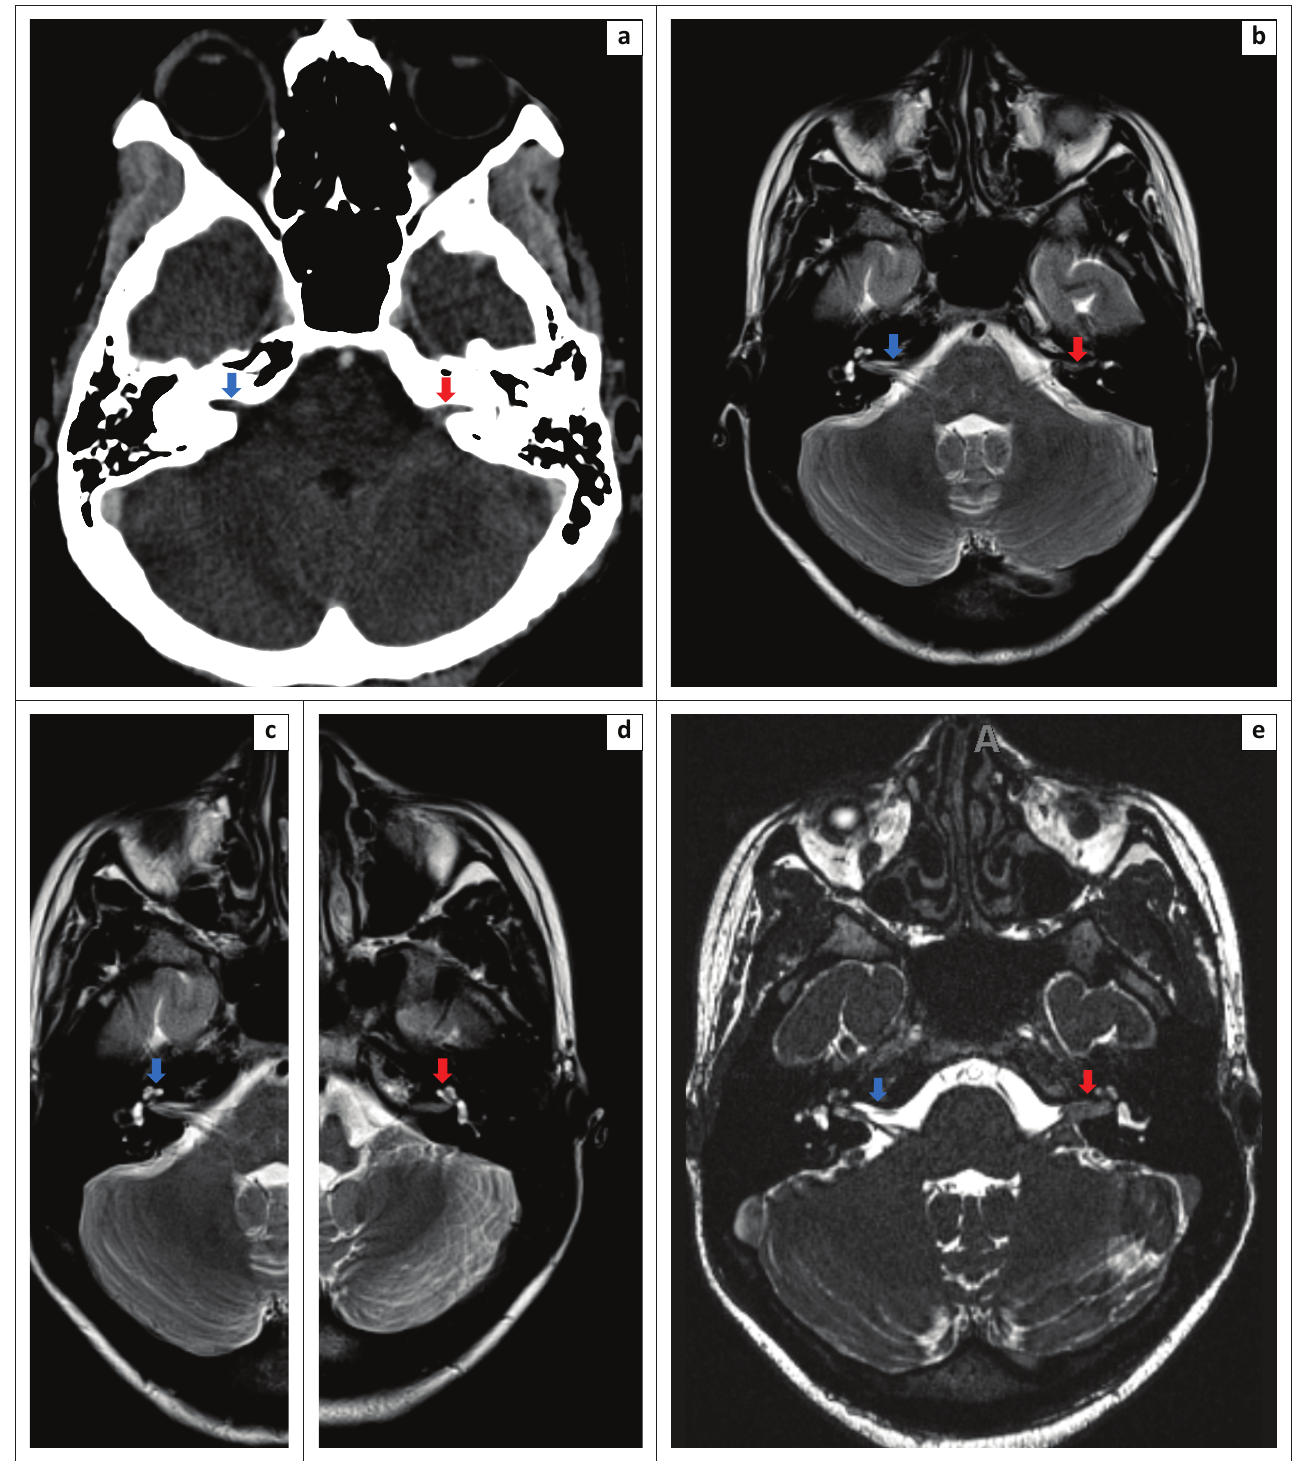
FIGURE 2: (a) Axial CT brain scan demonstrated a hyperattenuating mass at the porous acousticus of the left internal acoustic canal (red arrow). There was mild contrast enhancement and the canal was not expanded. The right internal acoustic canal appeared normal (blue arrow). (b) Axial, T2W MRI of the IAC demonstrated loss of the normal CSF signal within the left IAC (red arrow). The right IAC demonstrated signal loss to a lesser extent (blue arrow). (c–d) Axial, T2W, MRI of the cochleae demonstrated partial loss of the normal CSF signal in the basal turns of the cochleae bilaterally (blue arrow in c indicating the right and red arrow in d indicating the left cochlea). (e) Axial, MRI, constructive interference in steady state sequence, demonstrated a notable mass within the left internal acoustic canal, with loss of the normal CSF signal (red arrow). This was seen to a lesser extent in the right internal acoustic canal (blue